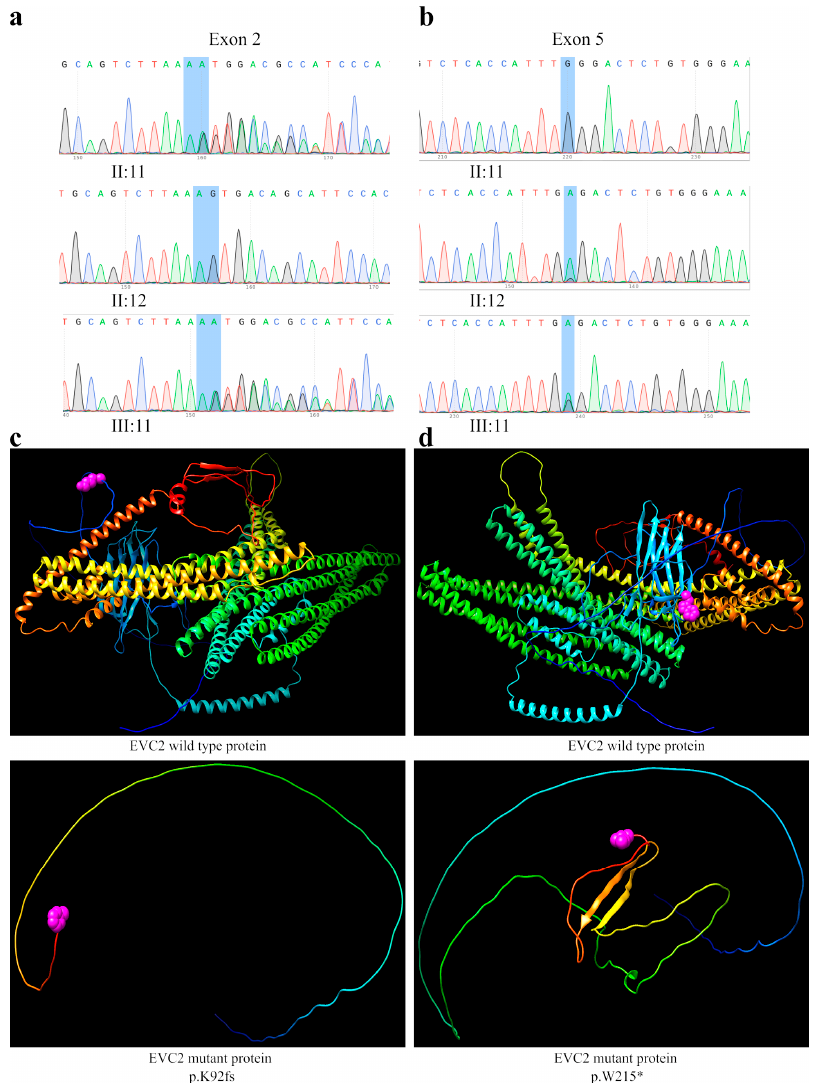
Figure 4. The results of the genetic analysis in the EVC2 gene in a pedigree with EvCS. ( a ) The results of Sanger sequencing. The patient (electropherogram III:11) and his father (electropherogram II:11) share a heterozygous frameshift variant of EVC2 —c.273dup, and p.K92fs in exon 2. The mother (electropherogram II:12) shows a normal EVC2 sequence. ( b ) The results of Sanger sequencing. The patient (electropherogram III:11) and his mother (electropherogram II:12) share a heterozygous nonsense variant of EVC2 : c.645G > A, p.W215* in exon 5. The father (electropherogram II:11) shows a normal EVC2 sequence. ( c ) Three-dimensional molecular models of the wild type EVC2 protein (upper panel), the EVC2 protein with heterozygous p.K92fs variant (bottom panel), the mutant EVC2 protein that generates truncated proteins; the pink bubbles indicate the last amino acid encoded. ( d ) Three-dimensional models of the wild type EVC2 protein (upper panel), and the EVC2 truncated protein with the heterozygous p.W215* variant (bottom panel); the pink bubbles indicate the last amino acid encoded.